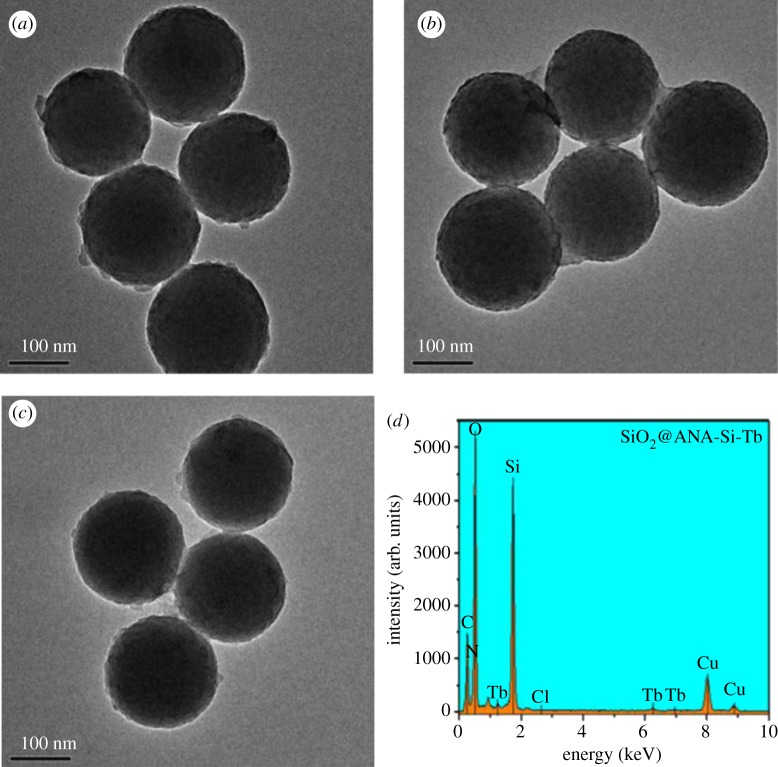
TEM images of SiO2@ANA-Si-Tb (a), SiO2@ANA-Si-Tb-phen (b), SiO2@ANA-Si-Tb-TTA (c) and EDX spectrum of SiO2@ANA-Si-Tb (d).